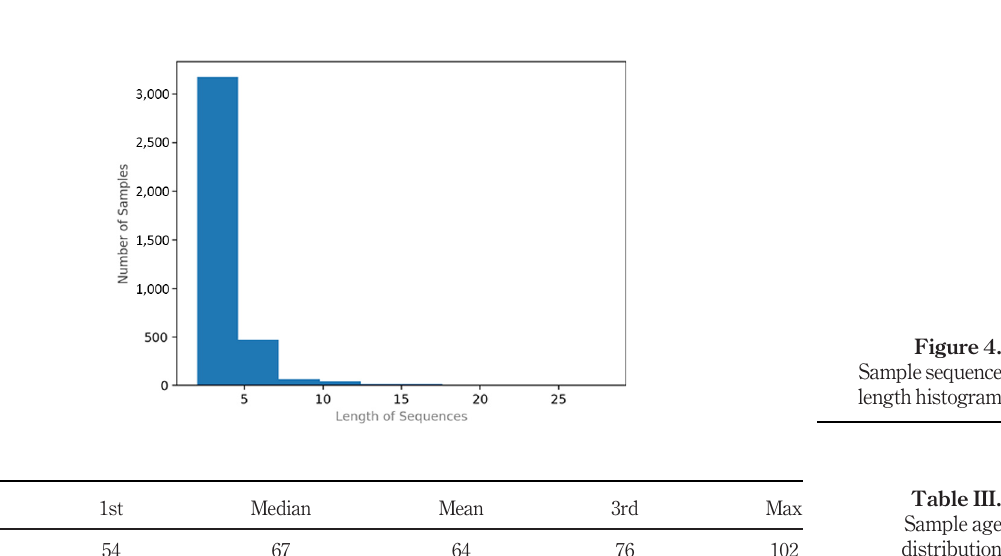
Table II. Disease